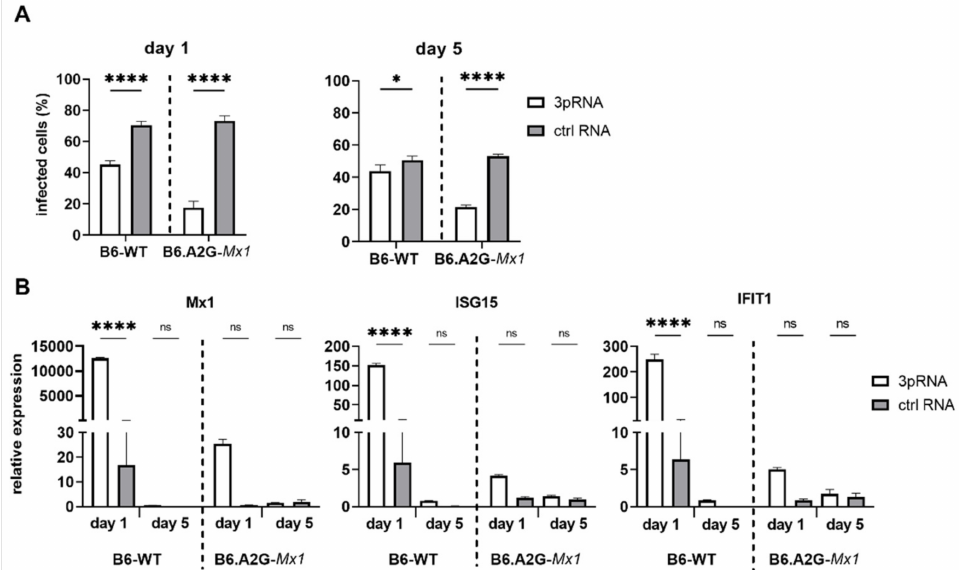
Figure 5. Treatment of primary mouse lung fibroblasts from B6-WT or B6.A2G- Mx1 mice with RIG-I agonists inhibits IAV and induces Mx1-dependent long-term protection. Primary mouse lung fibroblasts (MLF) were transfected with RIG-I agonist (3pRNA, 200 ng/mL) or control RNA (ctrl RNA, 200 ng/mL). ( A ) At 1 or 5 days after treatment cells were infected with HKx31 (MOI = 50), then fixed and stained for intracellular expression of the IAV NP at 8 hpi. Cells were analysed by flow cytometry. ( B ) RNA was harvested either 1 or 5 days after 3pRNA or ctrl RNA treatment. Expression of Mx1, ISG15 and IFIT1 was assessed by qRT-PCR. Expression was normalized to GAPDH and expressed as fold induction relative to untreated cells. Data represent the mean ( ± SD) from triplicate samples and are representative of 2 independent experiments. In ( A , B ), a two-way ANOVA with Bonferroni’s multiple comparison test was performed to compare 3pRNA and ctrl RNA